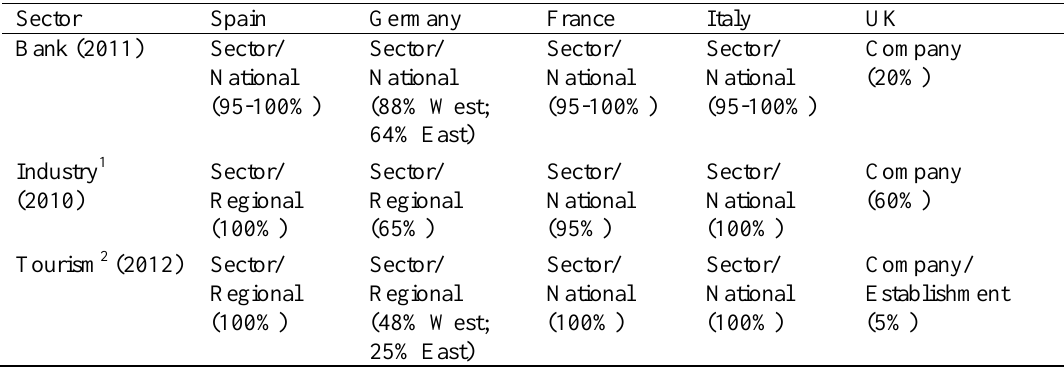
Table 1 . Collective Bargaining predominant at sectoral level and coverage rate (%). Bank, Industry, and Tourism. Spain, Germany, France, Italy, and the